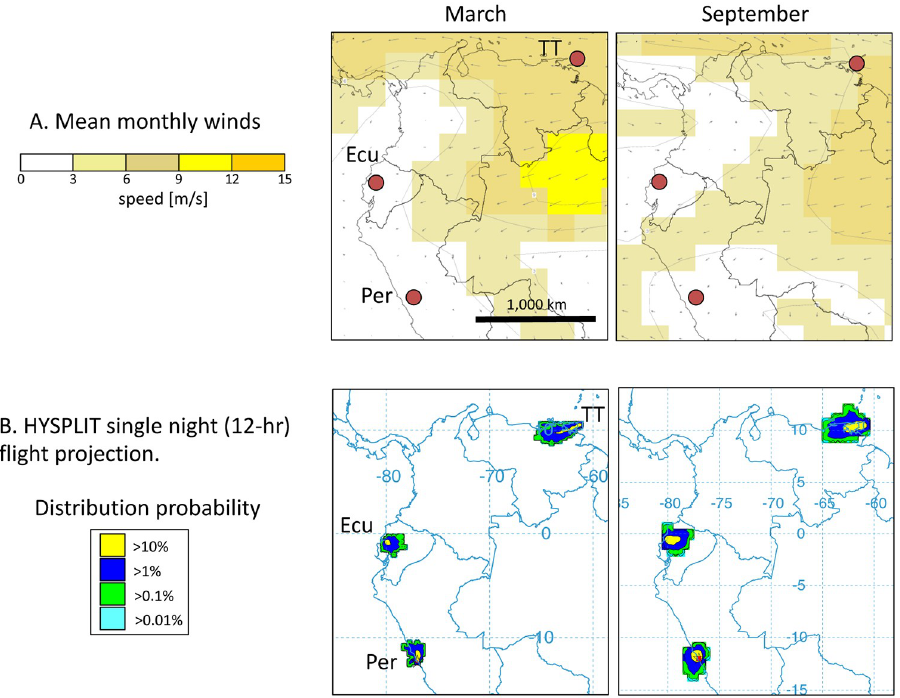
Fig 6. Maps indicating wind conditions in Ecuador and surrounding regions. A. Map of vector mean winds Ecuador and surrounding areas . Climatology of monthly vector mean winds from March and September at the 925-mb pressure-height from NCEP-NCAR Reanalysis data using the 1981–2010 base period. TT, Trinidad-Tobago; Ecu, Ecuador; Per, Peru. B. HYSPLIT forward projections of 12-h overnight trajectories at 500 m AGL based on historical wind data. Average monthly trajectories for selected months are displayed as a frequency distribution from Ecuador (Ecu: -0.78, -80.22), Peru (Per: -12.08, -76.93), Trinidad and Tobago (TT: 10.65, -61.43).